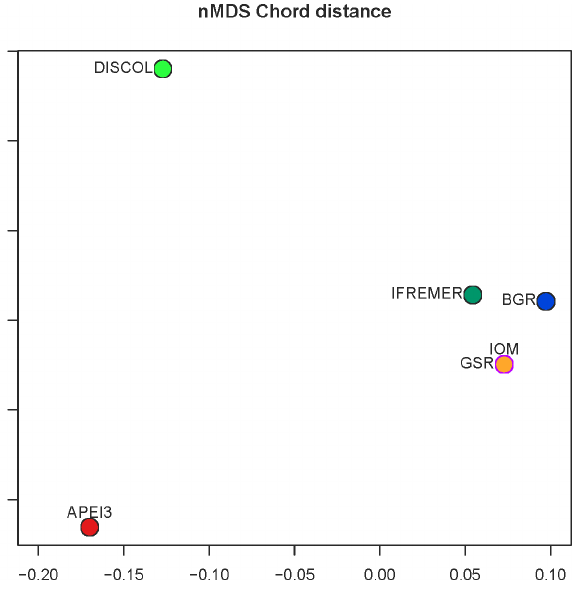
Figure 9. The nMDS ordination plot of chord distance between ar- eas.